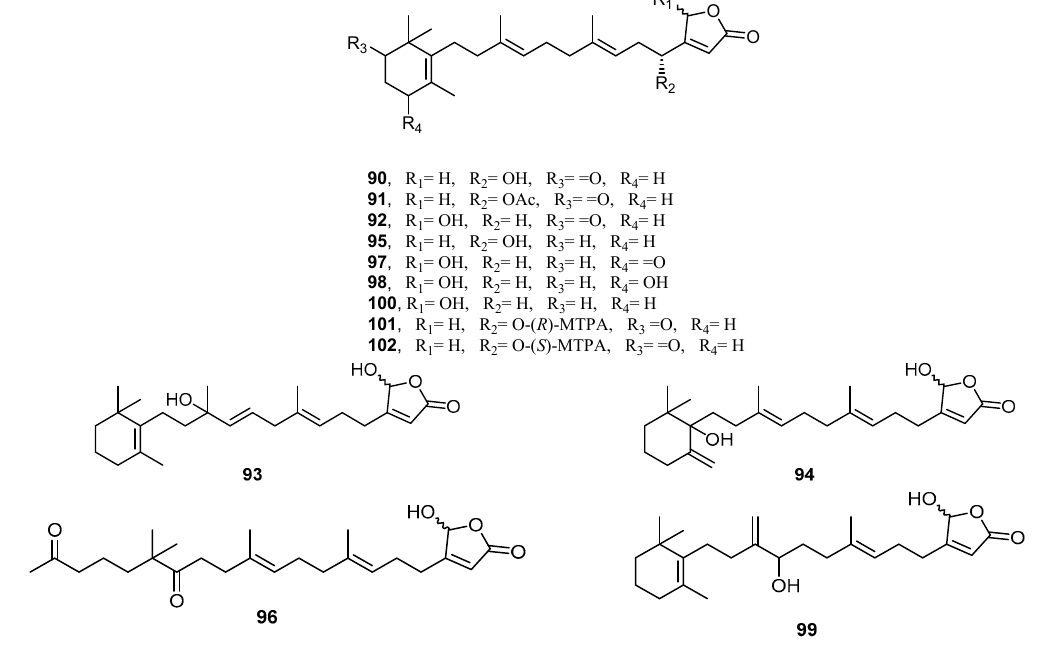
Figure 22. Chemical structures of the sesterterpenes 90 – 102 .